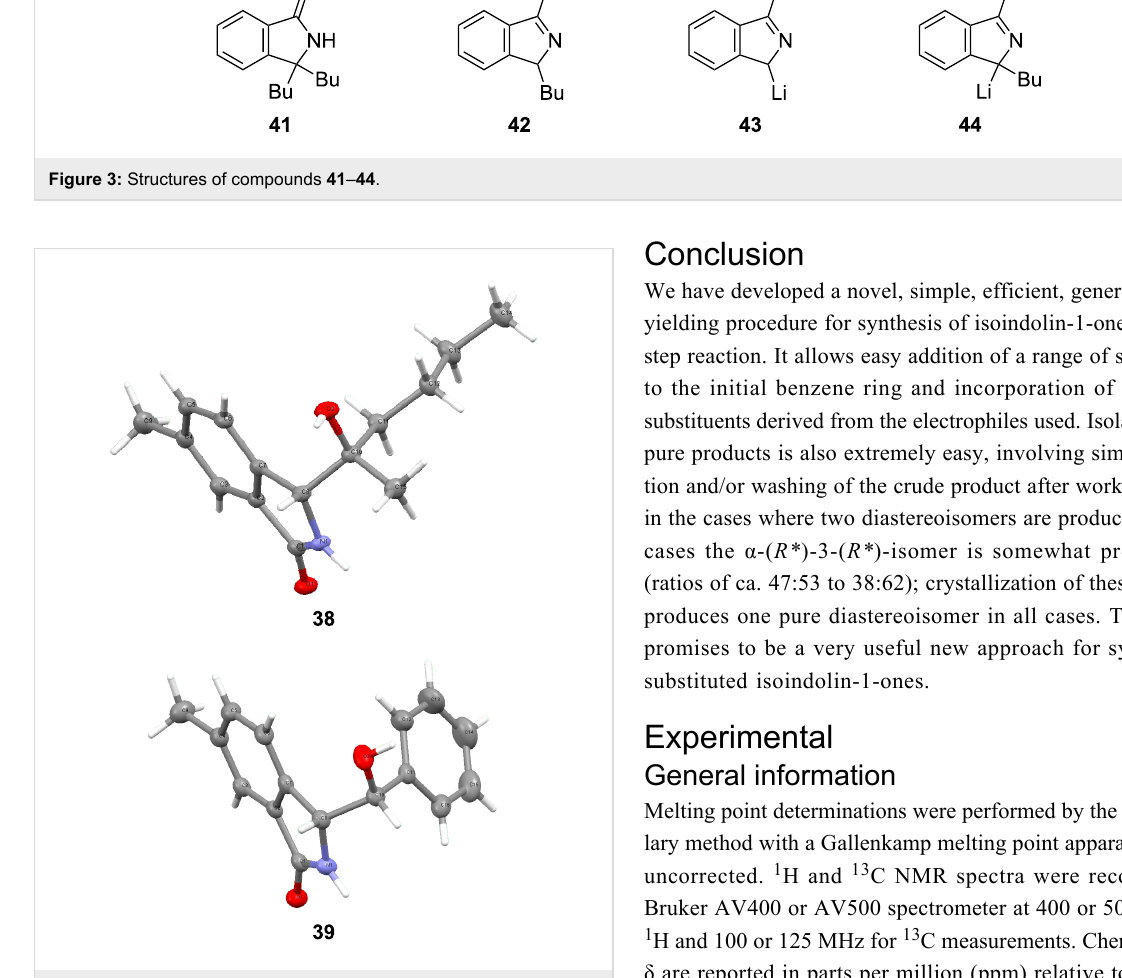
Figure 4: X-ray crystal structures of compounds 38 and 39 .